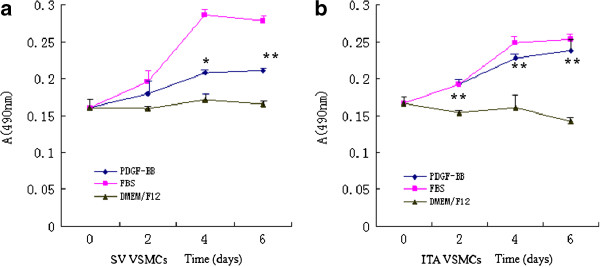
Proliferation assay of VSMCs from SV & ITA using MTT Kit. a). growth curve of SV VSMCs: b). growth curve of ITA VSMCs. P-value: obtained by paired t-test between group PDGF-BB and group DMEM/F12 using SPSS 13.0 (*P < 0.05; ** P < 0.01).